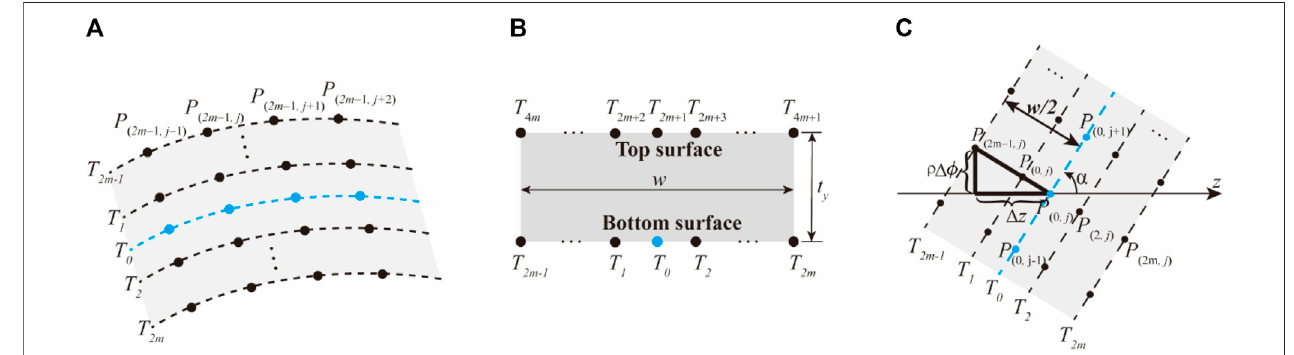
FIGURE 4 | Representation of the width and thickness of a yarn. (A) Representation of the width of yarn; (B) yarn cross-section expressed as a rectangle; (C) position of multiple parallel trajectories of a yarn path in relation to the